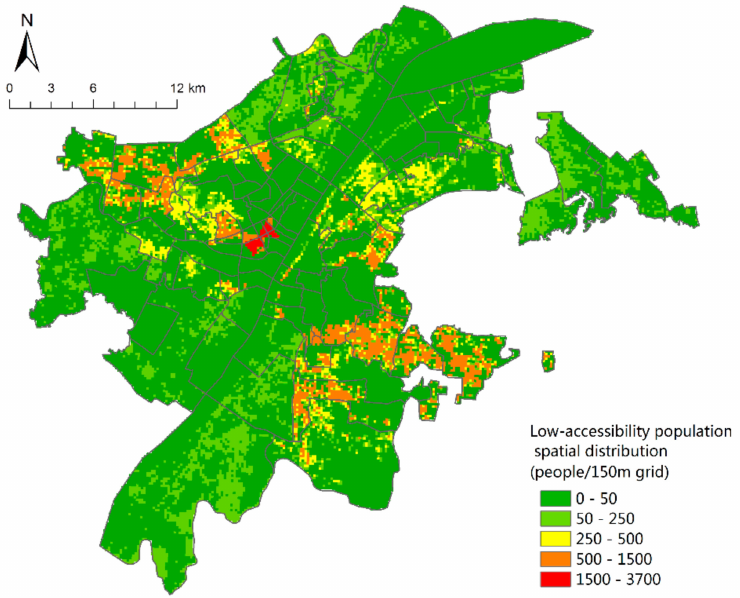
Figure 8. Low-accessibility population spatial distribution.